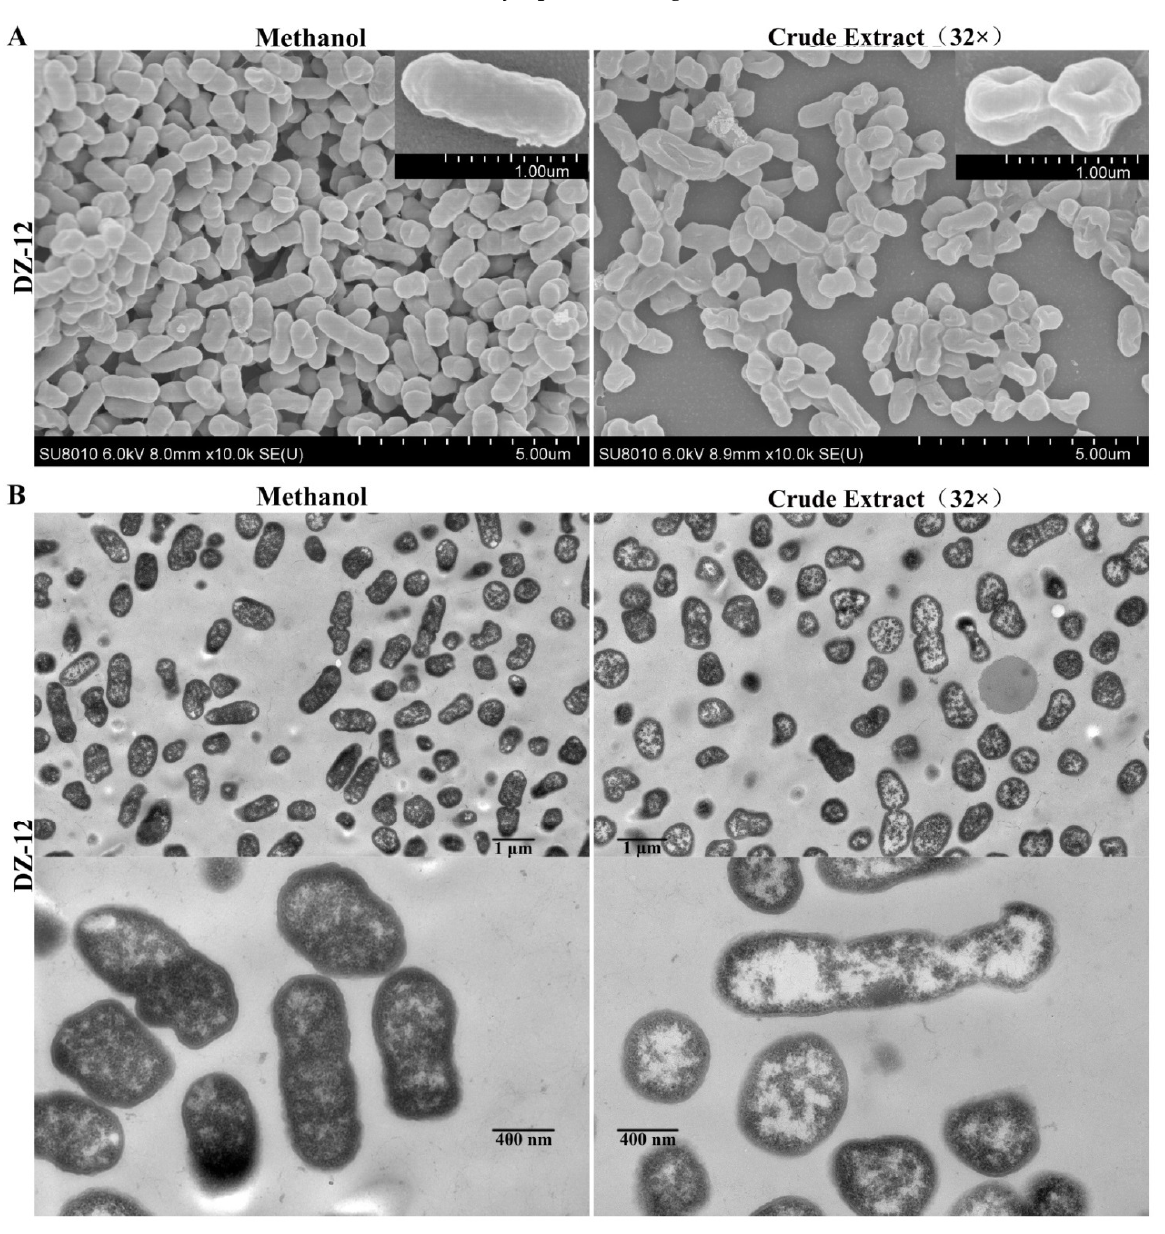
Figure 6. Effect of crude extract on the micro- and ultra-structures of the P. ananatis DZ-12 cells, as determined by SEM ( A ) and TEM ( B